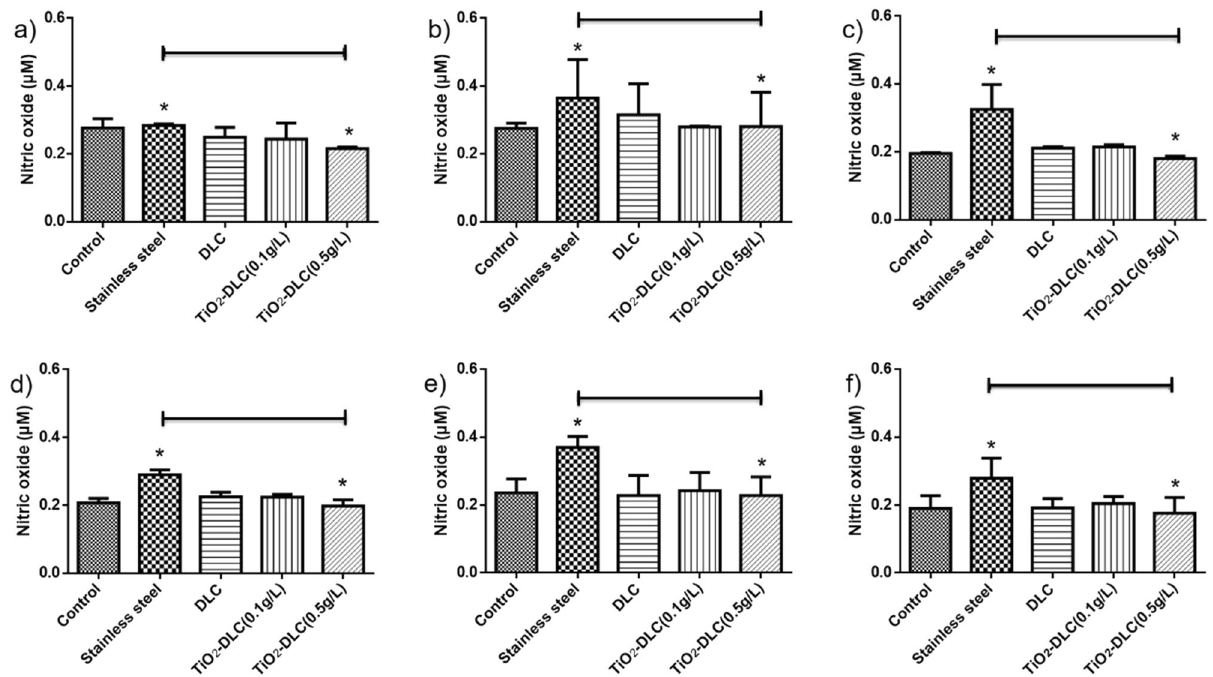
Fig. 3 Nitric oxide in the supernatant of the macrophage cultures after 24 ( a ) – ( c ) and 48 h ( d ) – ( f ). Implants after ( a ) 7, ( b ) 15, and ( c ) 30 days, after 24 h of the macrophage cultures; and implants after ( d ) 7, ( e ) 15, and ( f ) 30 days, after 48 h of the macrophage